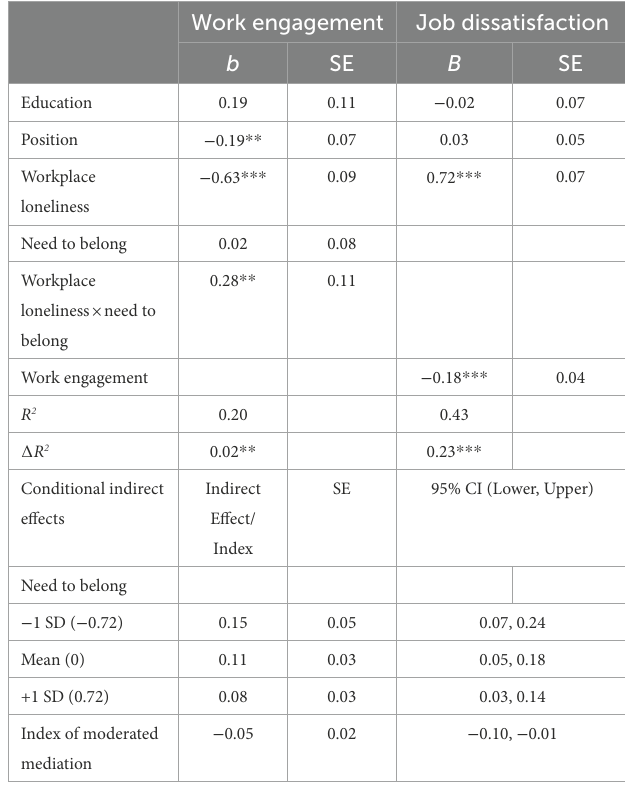
TABLE 4 Regression results for conditional indirect